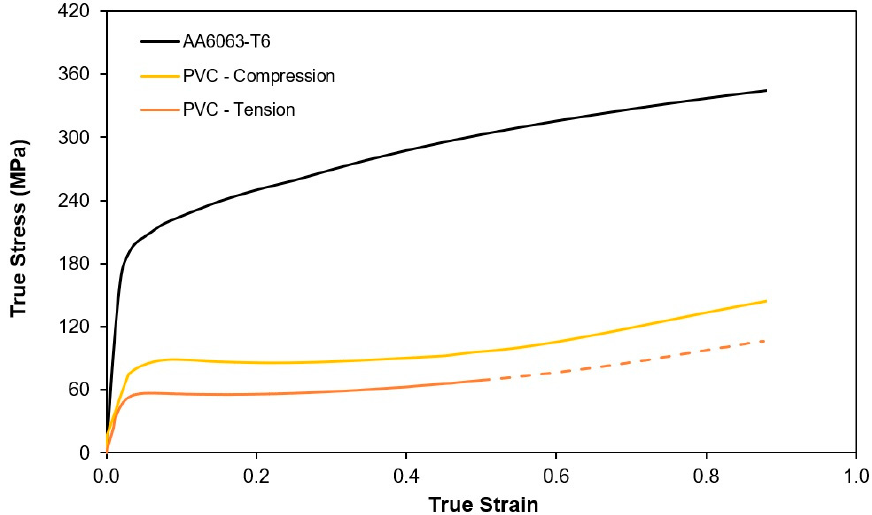
Figure 4. Flow curves of the PVC sheets and of the Aluminum AA6063 ‐ T6 tubes at ambient tem ‐ perature.